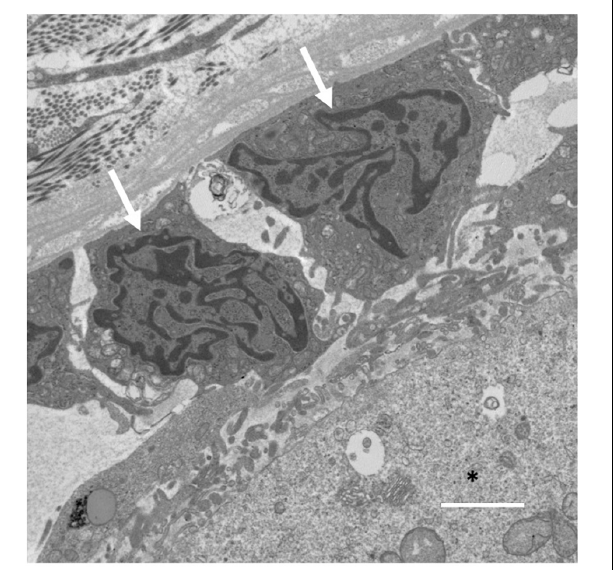
FIGURE 2 | Electron micrograph of an ovarian follicle at the oocyte-granulosa cell interface, with the oocyte identified using a black asterisk, and two granulosa cells identified with white arrows. Scale bar represents 2 µ